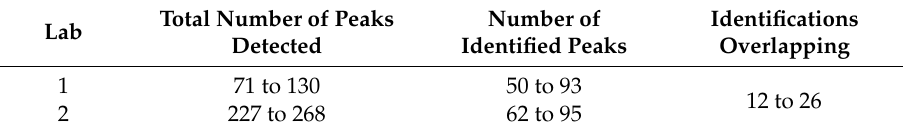
Table 3. GC-MS Interlaboratory metabolite coverage and overlap.